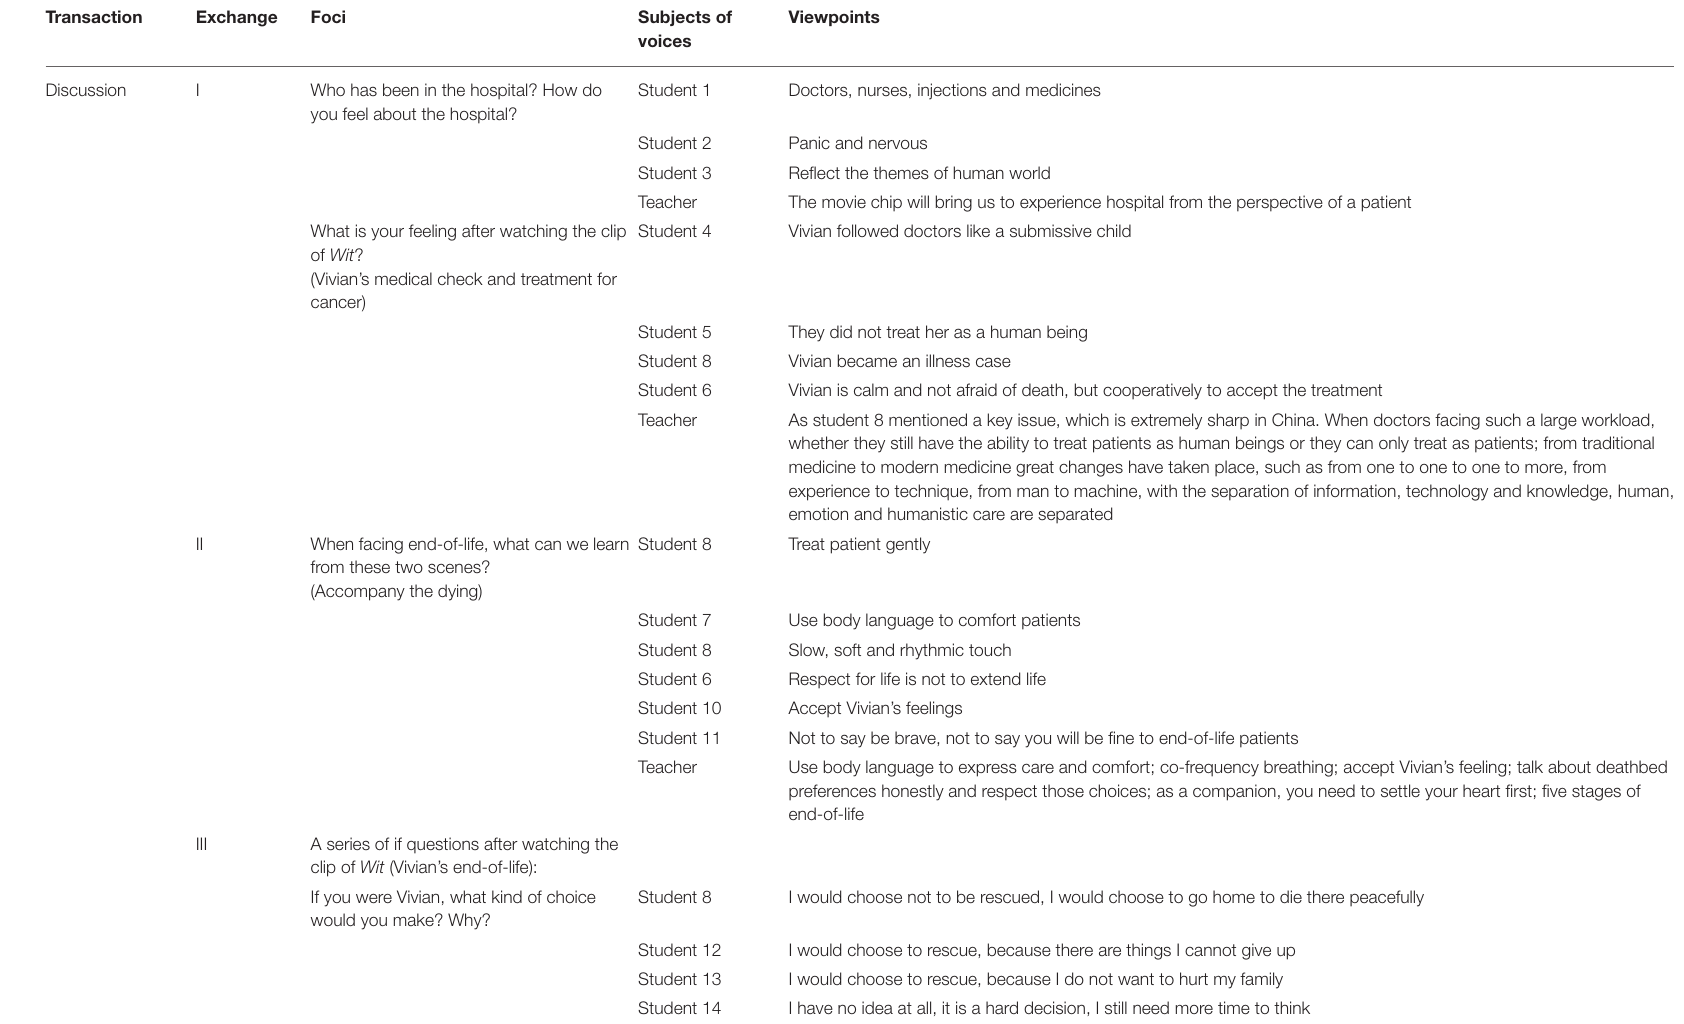
TABLE 1 | The voices constructed on end-of-life in the classroom.